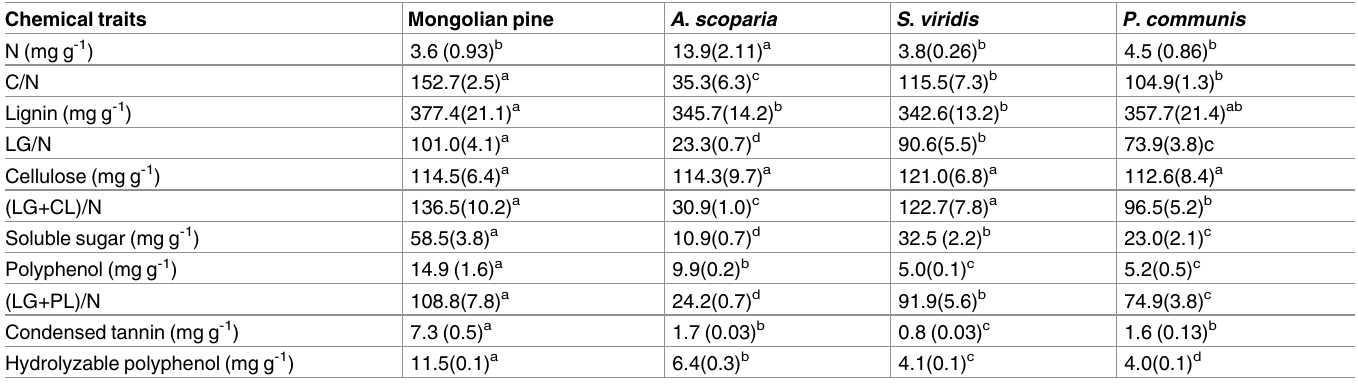
Table 1. Initial litter chemical traits ( ± SE, n = 4) of four